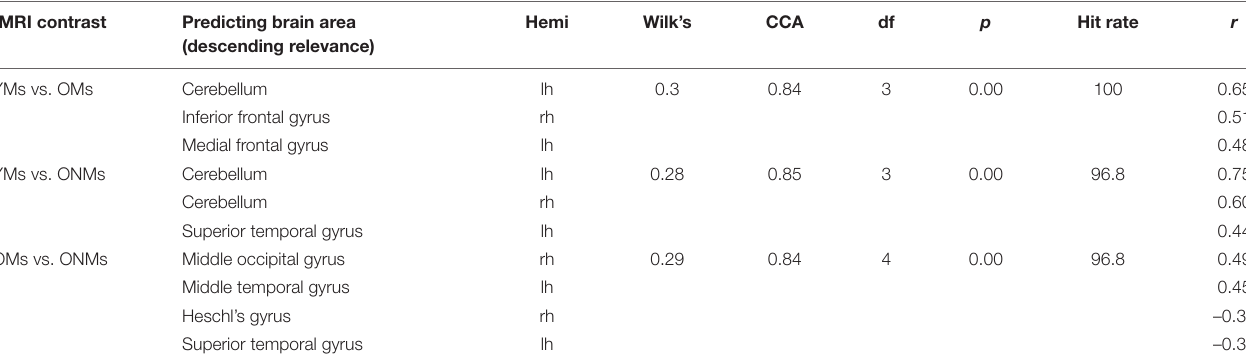
Results of the two-group level discriminant function analysis of functional ROIs. The functional ROIs are based on the beta-values of individual regions from group contrasts. Hemi, hemisphere; lh/rh, left hemisphere/right hemisphere; YMs, young musicians; OMs, old musicians; ONMs, old non-musicians; r, contribution to discriminant function; Hit rate, discrimination accuracy; Wilks’, Wilks Lambda test; CCA, canonical correlation analysis; df, degrees of freedom; ROI, region of